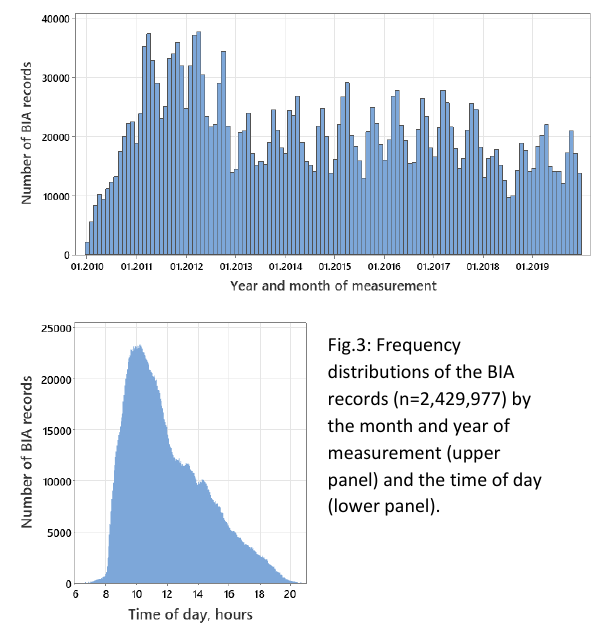
Fig.4: Frequency distribution of the BIA records (n=2,429,977) by the year of birth of the measured persons (upper panel) and of the total number of HCs according to the number of BIA measurements (lower panel).